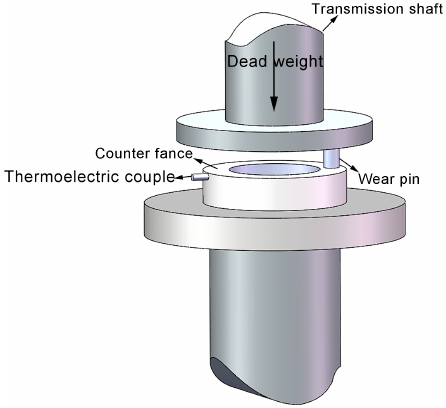
Figure 1. Schematic representation of ( a ) the surface welding and ( b ) the sampling location.